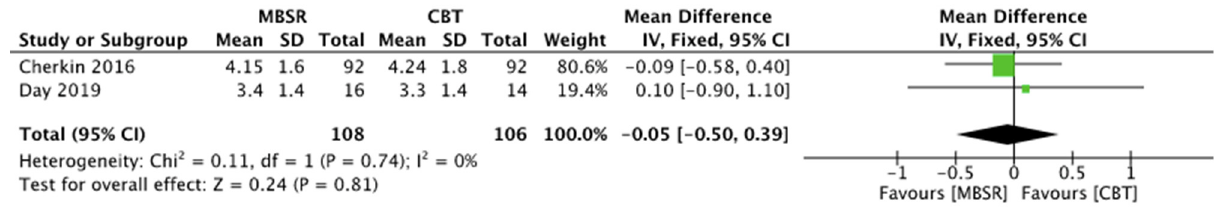
Figure 4. Pain: MBSR versus CBT.